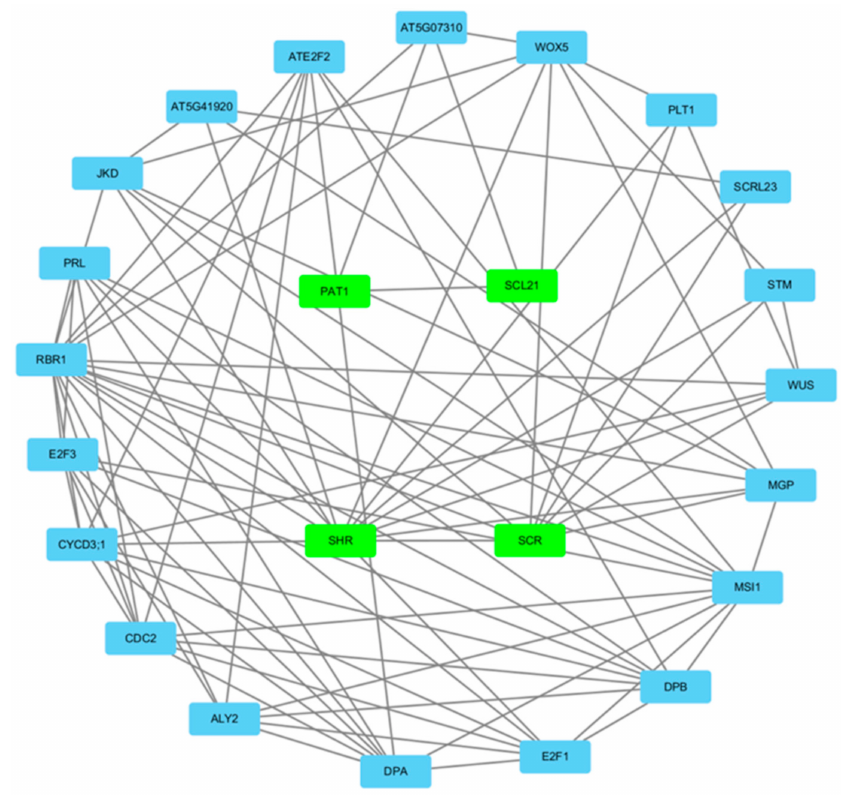
Figure 4. Avena sativa GRAS protein interaction network diagram.